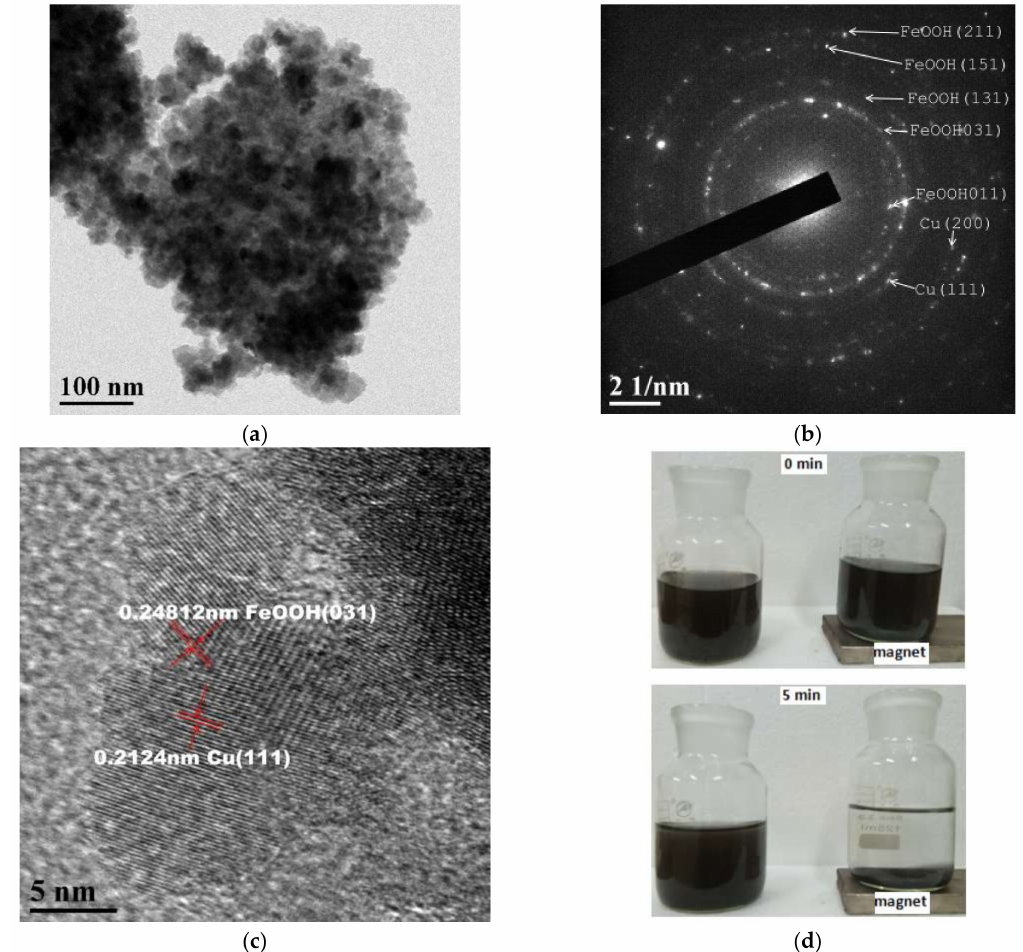
Figure 2. ( a ) Microstructure, ( b ) selected area electron diffraction (SAED), ( c ) high-resolution transmission electron microscopy (HRTEM), and ( d ) macroscopic morphology of FeOOH/Cu in aqueous